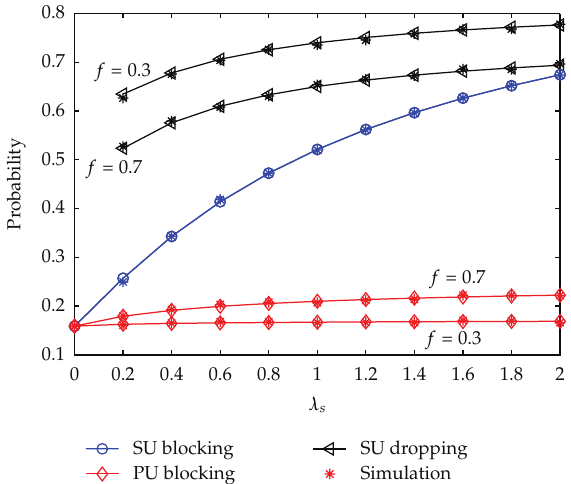
Figure 5: Blocking and dropping probabilities versus λ s in SUPC mode. The systems parameters are N (cid:8) 20, μ p (cid:8) μ s , λ p (cid:8) 1 and f (cid:8) 0 . 3 , 0 .